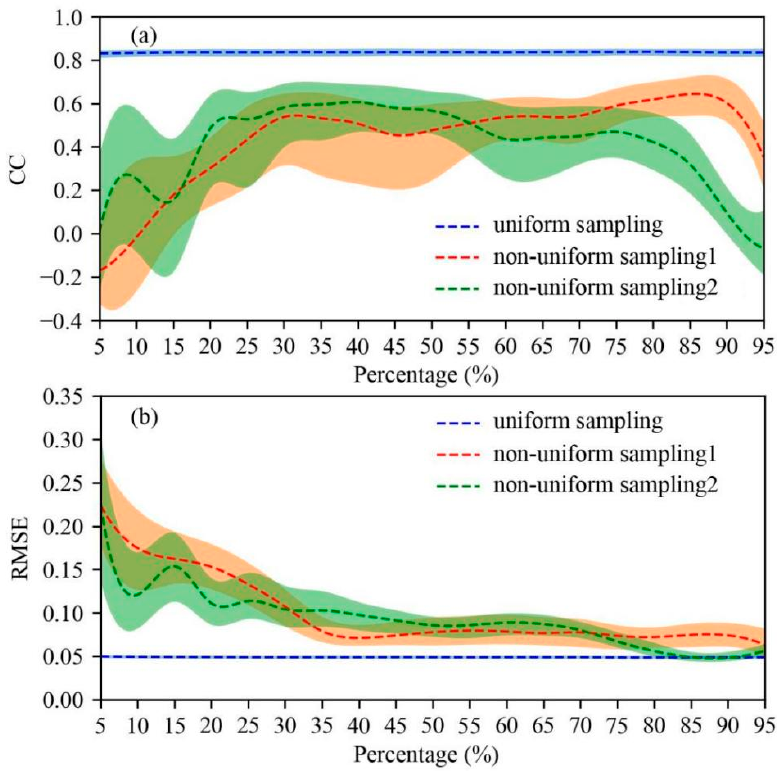
Figure 13. ( a ) The correlation coefficients and ( b ) root mean square errors for the RF gap ‐ filling procedure in the spatial domain under different percentages of data coverage by uniform and non ‐ uniform sampling schemes for model training over China.